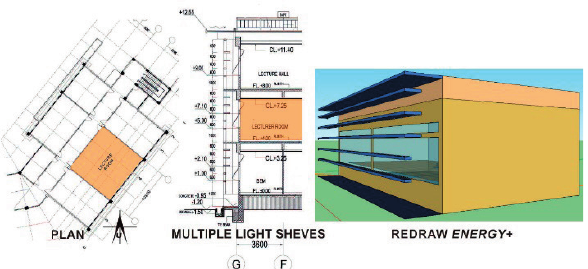
Fig. 2. Redraw for Energy + Simulation Source: taken from the existing